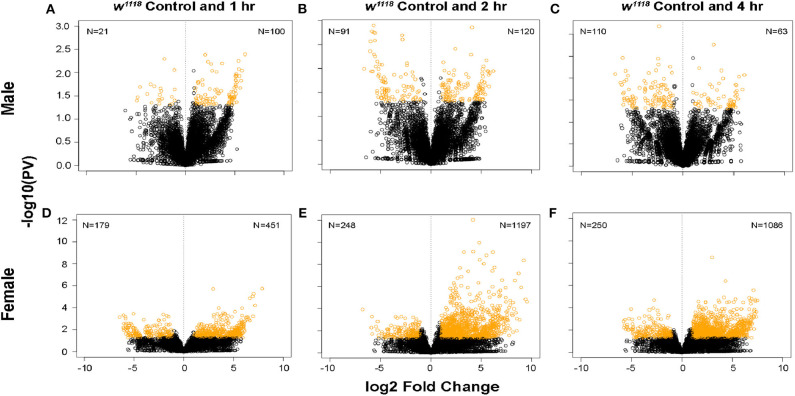
Gene expression changes after TBI in male and female flies. Volcano plots depicting log2 fold change and –log10(PV) of differentially expressed genes at 1, 2, and 4 hr after injury compared to control are indicated for males (A–C) and females (D–F). The number of significantly upregulated and downregulated gene changes are indicated in yellow in each plot (|log2FC| > 1; p < 0.05). Females show more upregulated gene expression in response to injury than males.